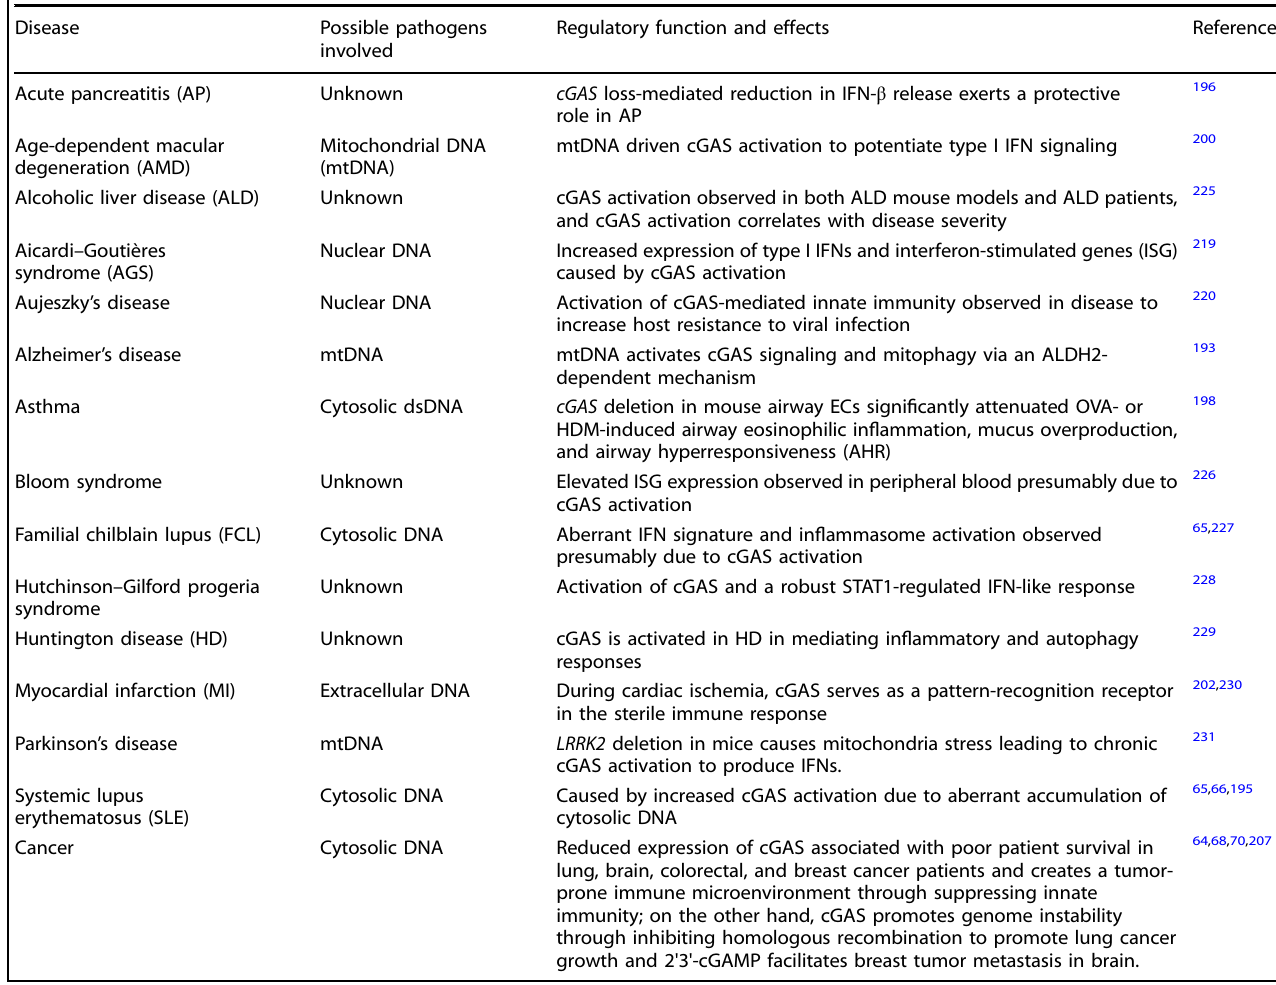
Table 2. Human diseases related to deregulated cGAS signaling Disease Possible pathogens Regulatory function and involved